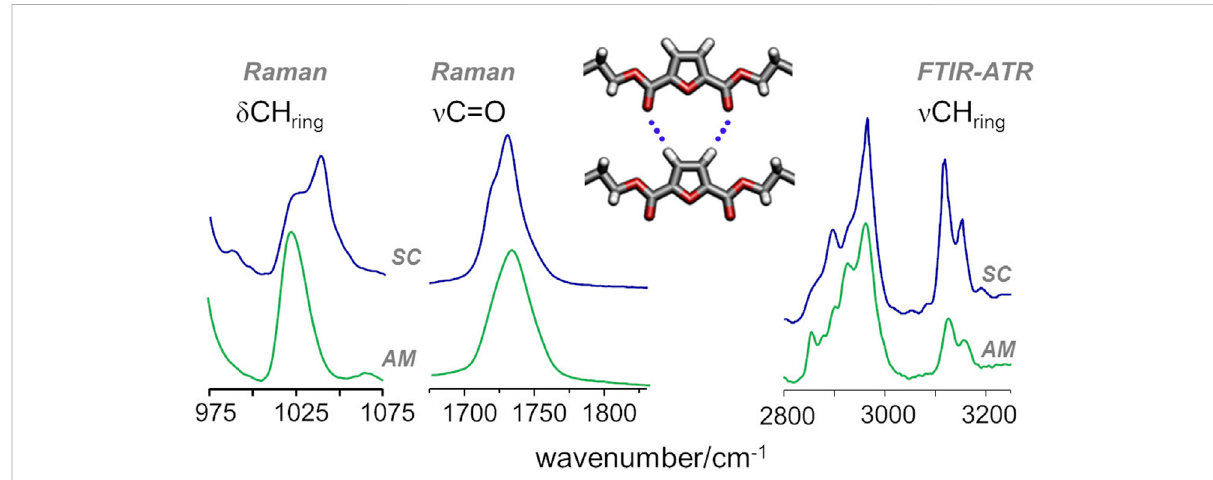
FIGURE 6 Raman and infrared spectra of amorphous (bottom) and semicrystalline (top) samples of PBF, highlighting the CH deformation ( δ CH ring ) and stretching ( ν CH